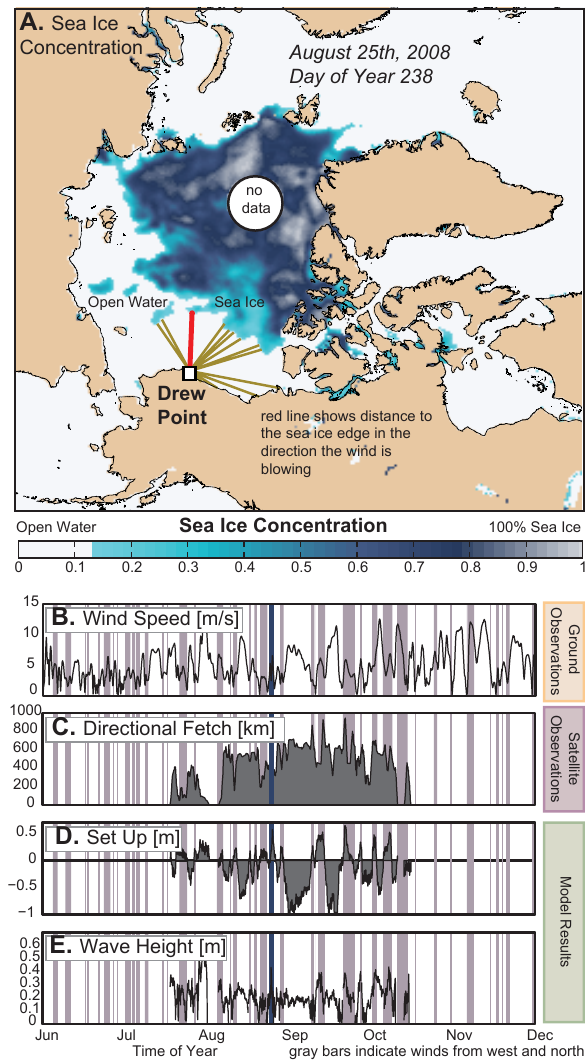
Figure 9. The “directional fetch” is the distance to the sea-ice edge in the direction from which the wind is blowing. The directional fetch is constructed using the hourly wind field from Barrow, ad- justed for Drew Point, and the daily location of the sea-ice edge. The upper panel shows sea-ice concentration on 25 August 2008, with distance to the sea-ice edge in the direction from which the wind is blowing at that time (red line) and other azimuths (yellow lines). The directional fetch is used as the maximum distance over which water can be set up or set down and waves can be generated. Based on the wind speed, wind direction, and directional fetch, the setup and set down are calculated (lower